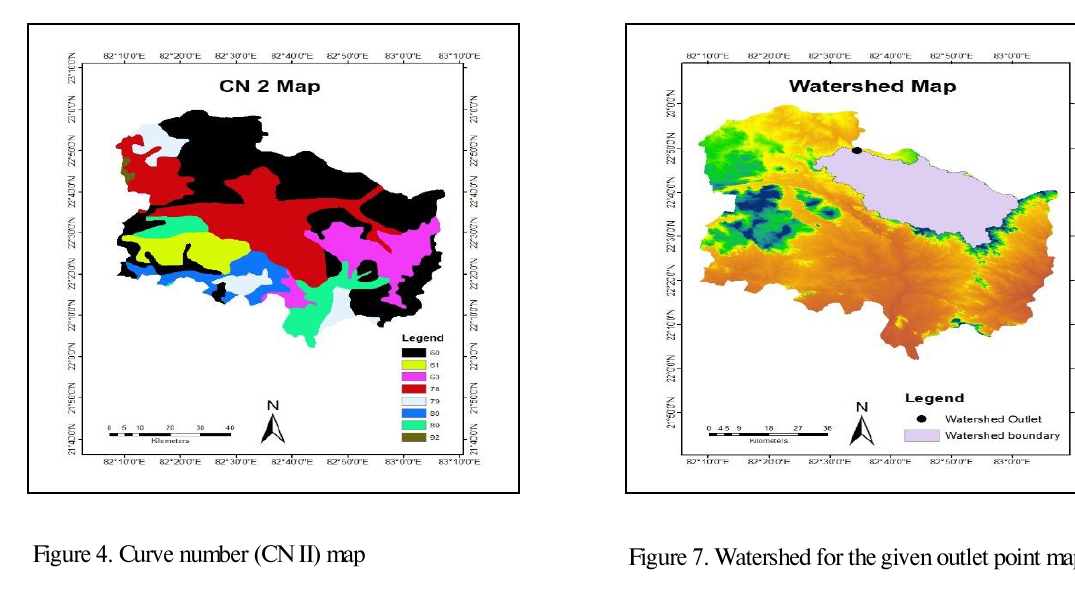
Figure 7. Watershed for the given outlet point